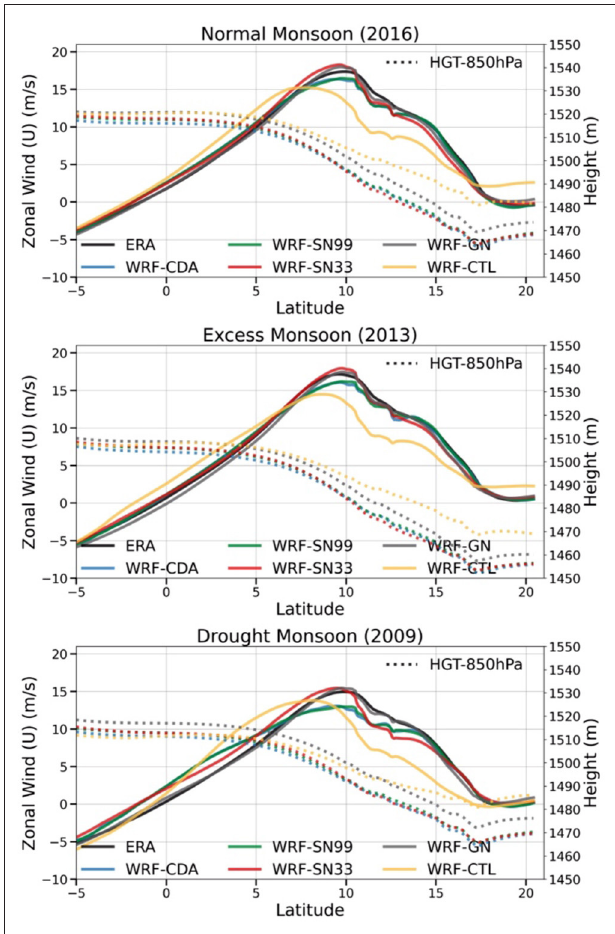
FIGURE 5 | Latitudinal section of the mean seasonal zonal winds (m/s) and geopotential heights (m) at 850 hPa averaged over the longitudes 50–60 E during normal (2016), excess (2013), and drought (2009) Indian Summer Monsoon